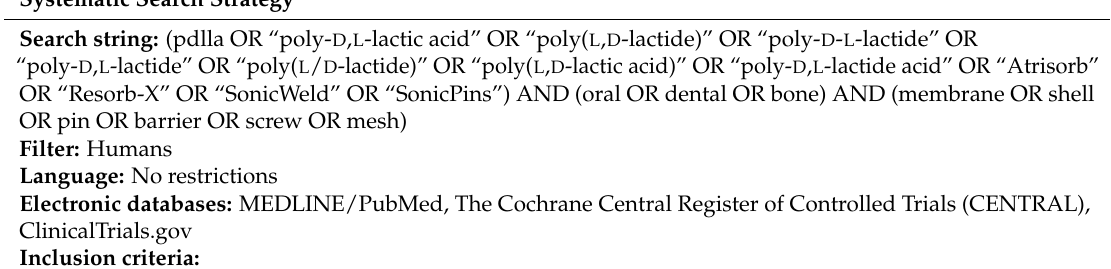
Table 1. Systematic search